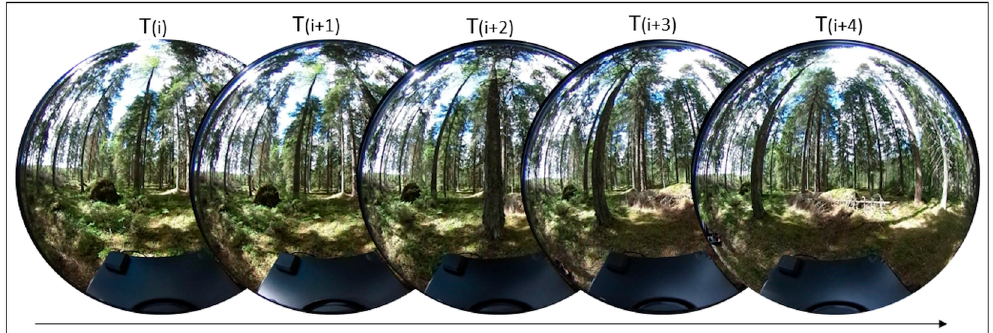
Figure 2. Example of sequential omnidirectional images acquired in a forest area using the Personal Mobile Terrestrial System.